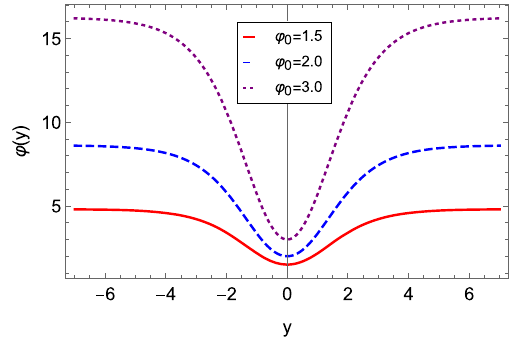
Fig. 1 Numerical solutions for the scalar field ϕ ( y ) from Sect.